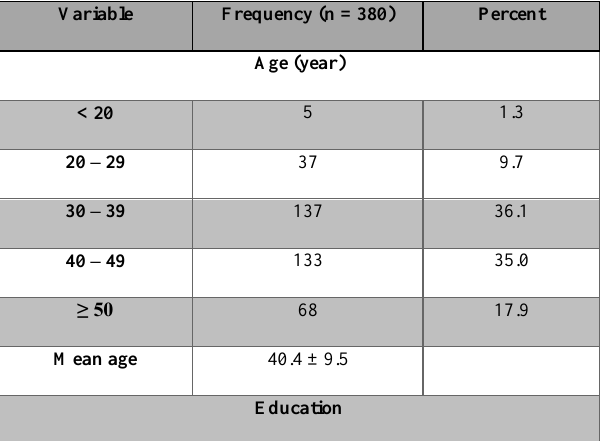
Table 2. Socio-Demographic Characteristics of Partners.